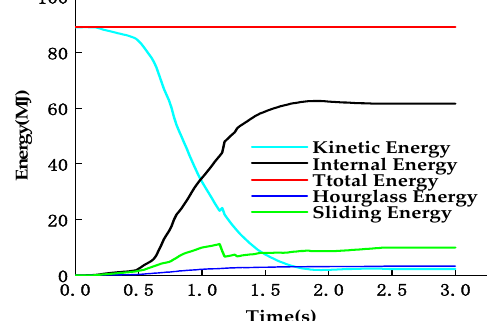
Figure 14. Energy diagram of the steel supporting.